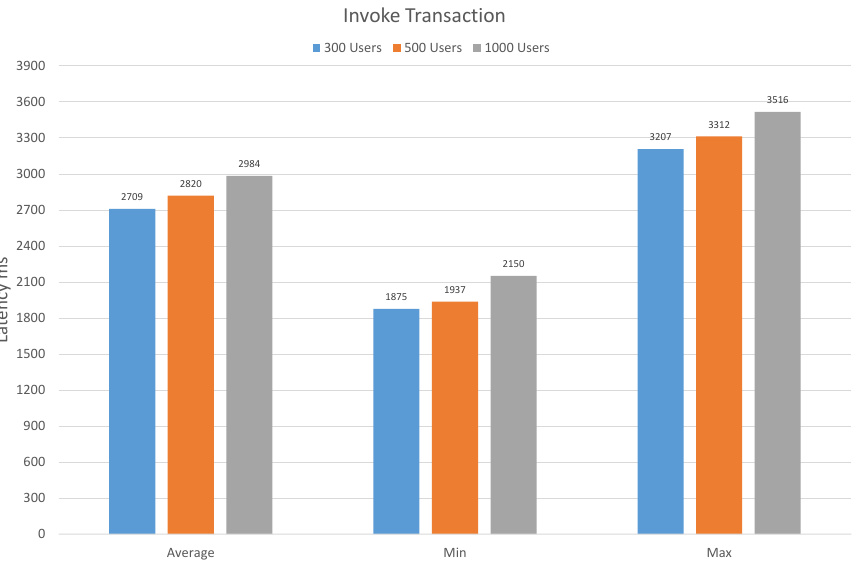
Figure 11. Latency in Invoke Transaction.